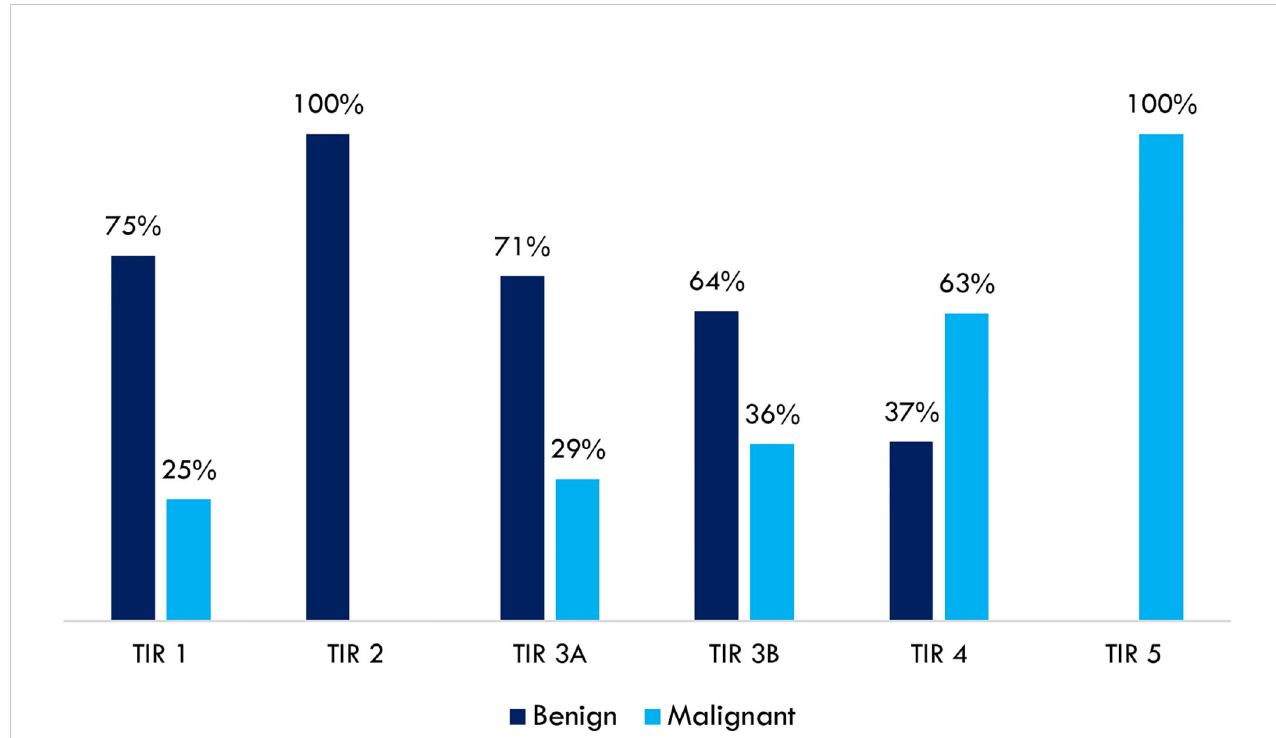
FIGURE 1 Concordance rates between thyroid cytology (SIAPeC-IAP 2014) and histological fi ndings dichotomized as benign or malignant (n =